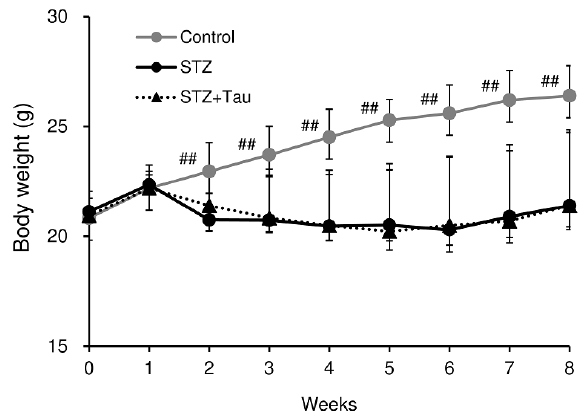
Figure 1. Changes in body weight in control, diabetic, and taurine-treated groups. Each value is expressed as the mean ± S.D. ( n = 8 – 12), ## p < 0.01 vs. STZ group.